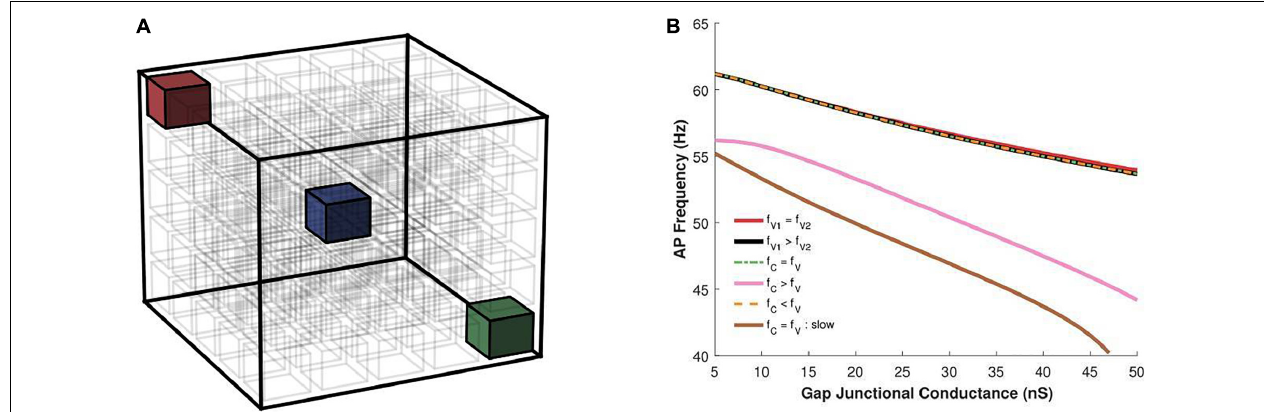
FIGURE 10 | (A) An illustration of a 5-cube syncytium showing locations where pacemaker cells were placed (two locations per simulation) are highlighted with colored cells, while all other cells have been left uncolored for easier visualization. The bounding box (in black) indicates the extent of the syncytium. (B) Action potential oscillation frequency measured in a syncytium of size 5-cube under presence of two oscillator cells in the syncytium at varying locations, as shown in panel (A) , with the two cells individually producing oscillations at either the same or different frequencies. f V , frequency of oscillator at vertex; f C , frequency of oscillator at center. The legend indicates how their oscillation frequencies compare for each trace. Note that the color of the cells in panel (A) do not correspond to the traces in panel (B) , and is only used to for clarity of description in the